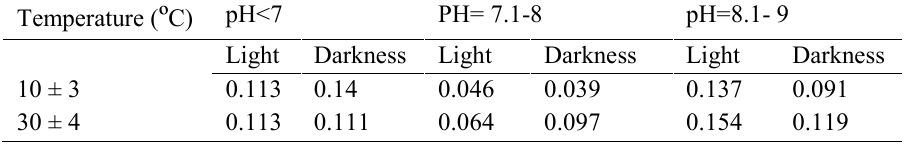
Table 2. The values of kinetic coefficients under different conditions in facultative stabilization